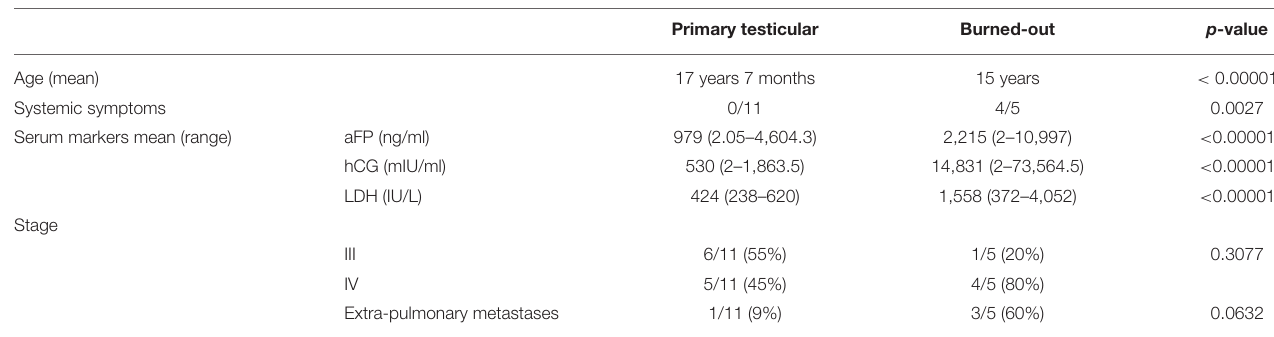
TABLE 1 | Patients’